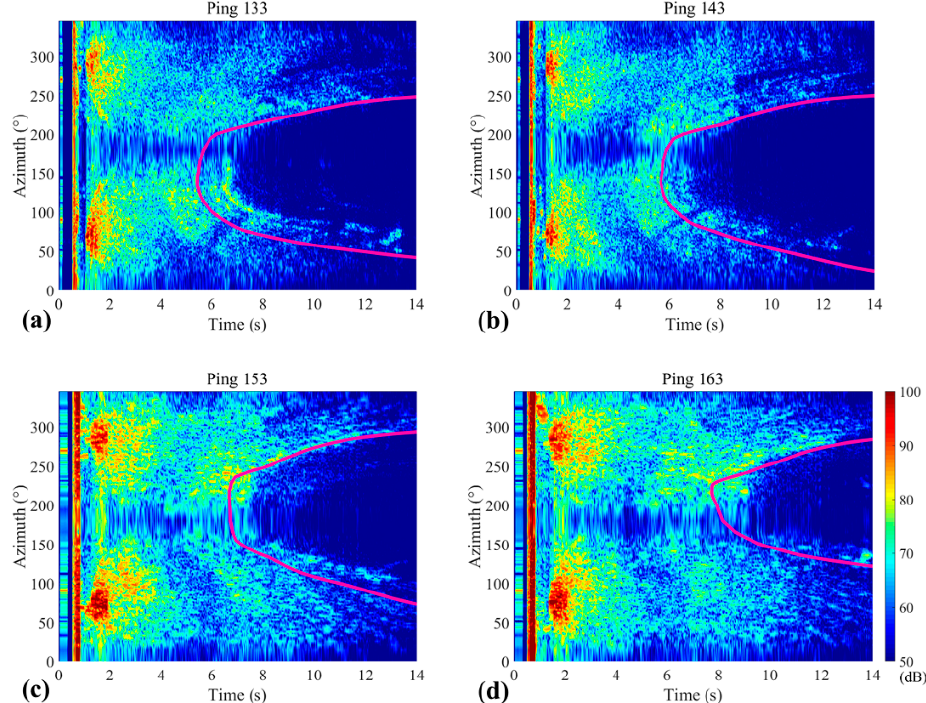
Figure 12. Comparison of measured BTRs and two-way MDP travel time+ curves: ( a ) ping 133, ( b ) ping 143, ( c ) ping 153, and ( d ) ping 163. The upper figures are for the 0.1-s pulse length and the lower figures are for the 0.3-s pulse length.